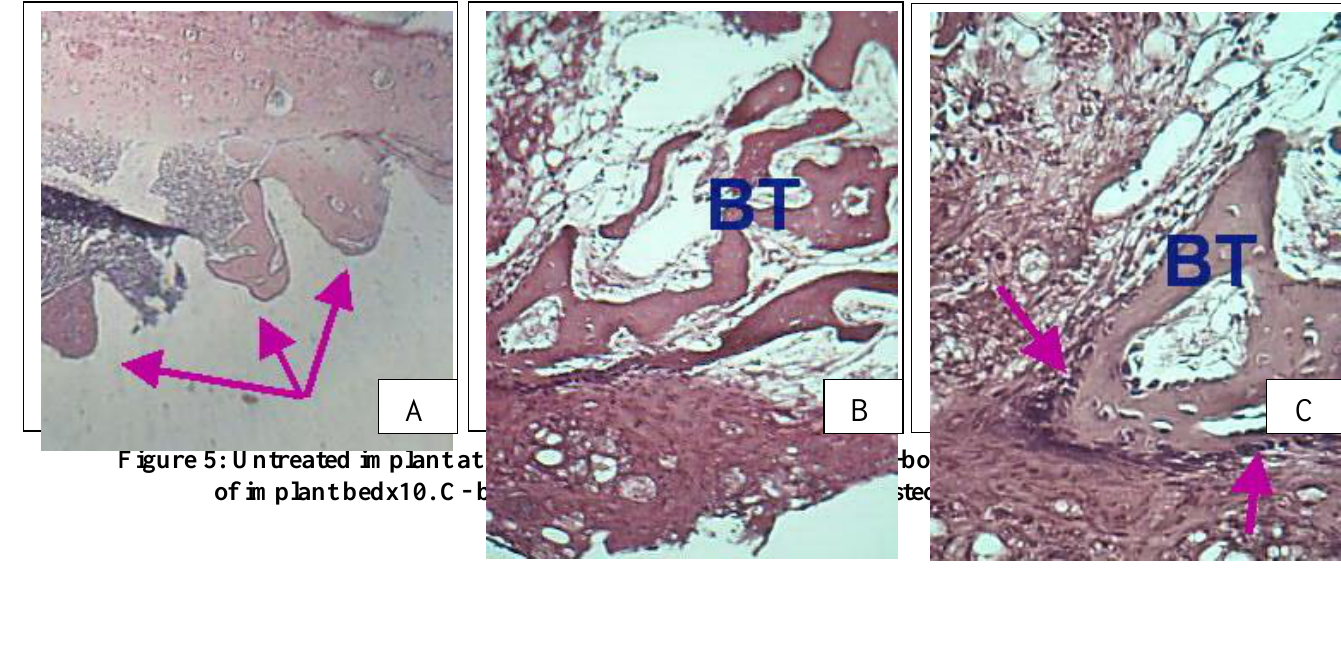
Figure 5: Untreated implant at 4 month: A- threads (arrows)x4. B-bone trabeculae (BT) at base of implant bedx10. C- bone trabeculae (BT) rimming by